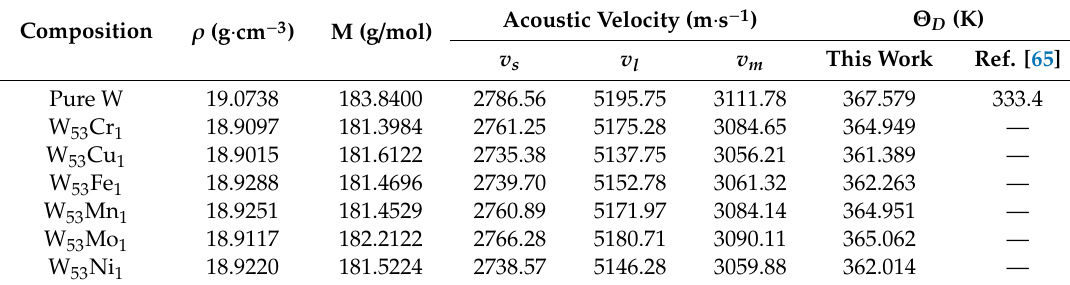
Table 3. Mass density ( ρ ), molar mass (M), shear sound velocity ( v s ), longitudinal sound velocity ( v l ), average wave velocity ( v m ) and Debye temperatures ( Θ D ) of pure W and the W-TM (TM = Cr, Cu, Fe, Mn, Mo and Ni, respectively)